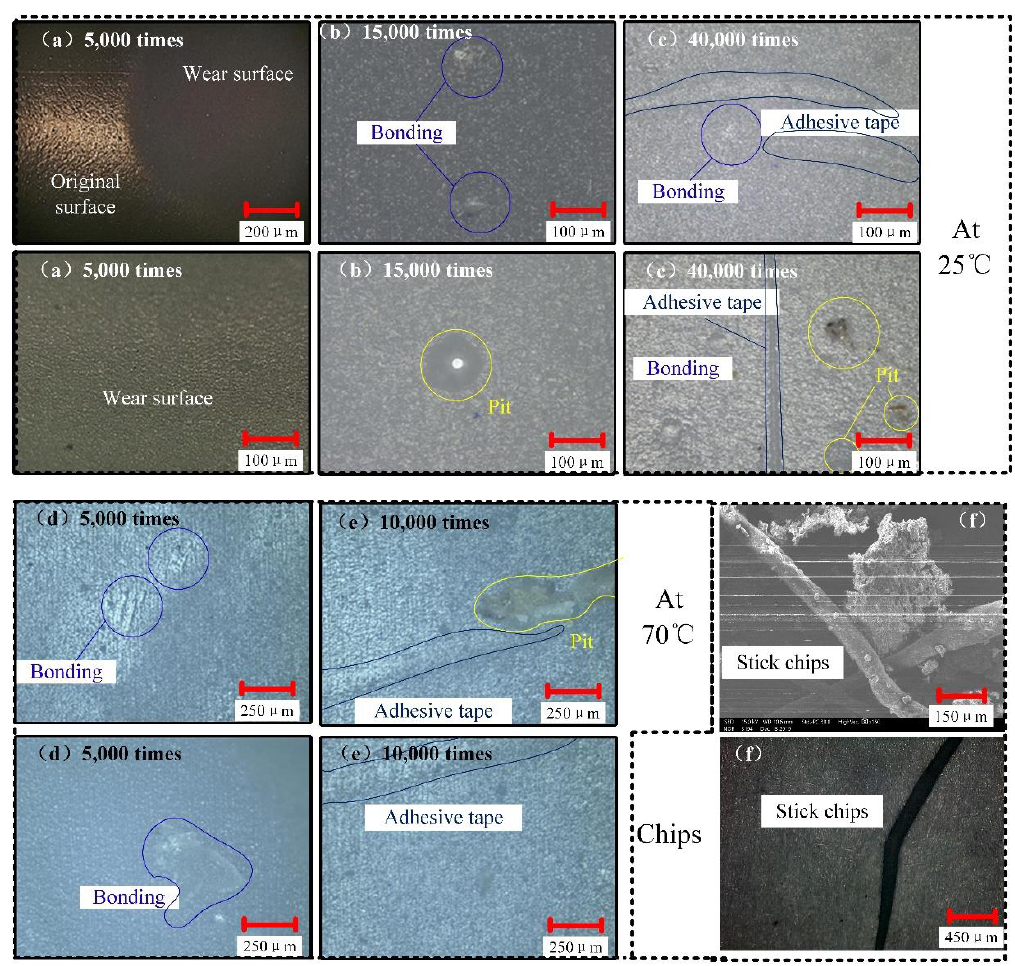
Figure 2. At 25 ◦ C, 2 kg, 5 mm / s, wear surface topography of cable at di ff erent friction times ( a ) 5000 times, ( b ) 15,000 times, and ( c ) 40,000 times; at 70 ◦ C, 2 kg, 5 mm / s, wear surface topography of cable at di ff erent friction times ( d ) 5000 times, ( e ) 10,000 times, and ( f ) wear chips topography.